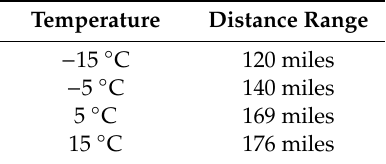
Table 5. Range variation against temperature for the Renault ZOE Battery Z.E.40 equipped with 16” wheels and driving at 50 mph